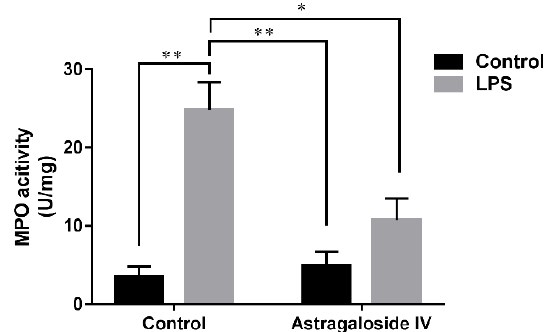
Figure 4. Effects of Astragaloside IV on myeloperoxidase (MPO) activity of LPS-induced uteri. MPO activity was determined at 24 h after LPS infusion. Two-way analysis of variance was performed with a Bonferroni post hoc multiple comparison test. Data are shown as mean ± SD. n = 6. * p < 0.05; ** p < 0.01.